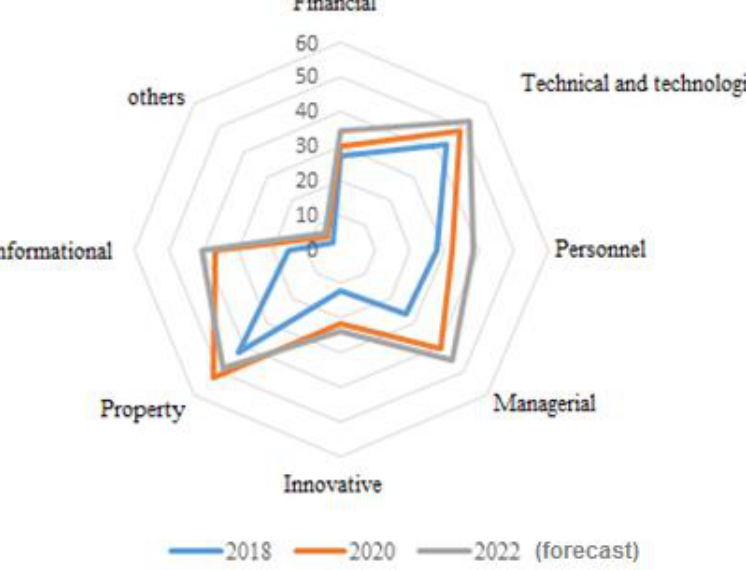
Figure 4. The results of the assessment of the group of internal risks of the enterprises of the cluster. Developed by Izmalkova I. and VertakovaYu.